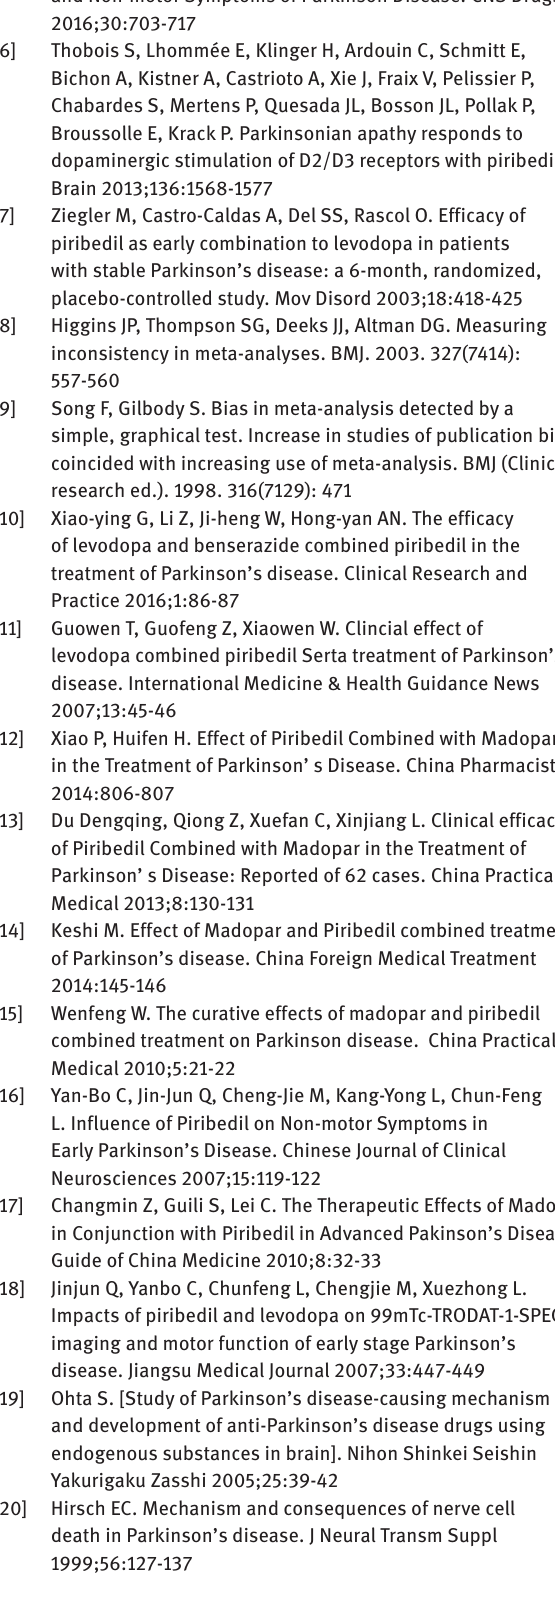
Funnel plot with pseudo 95% confidence limits